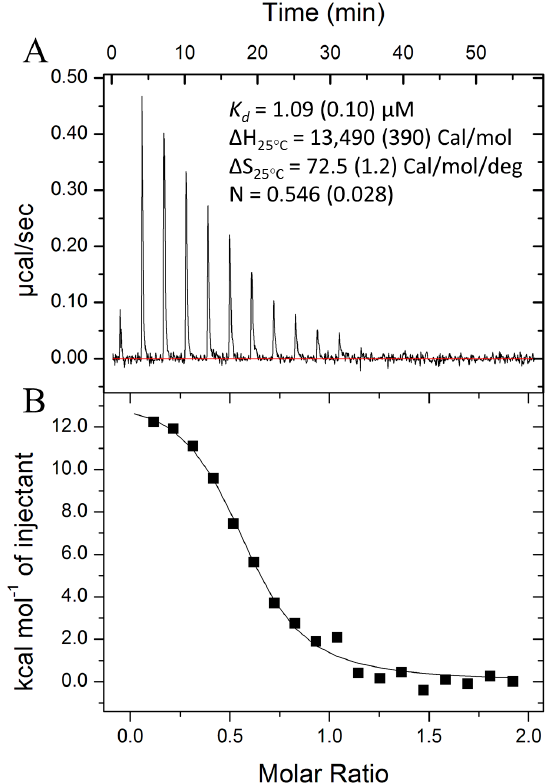
Figure 2. ITC analysis of the Csa3-cA 4 interaction. ( A ) Differential power recorded over the course of the ITC experiment for titration of 250 μ M cA 4 into 25 μ M Csa3a dimer. ( B ) Integration of areas under peaks corresponding to energy absorbed upon addition of cA 4 to Csa3a as a function of molar ratio [cA 4 ]/[Csa3a dimer].